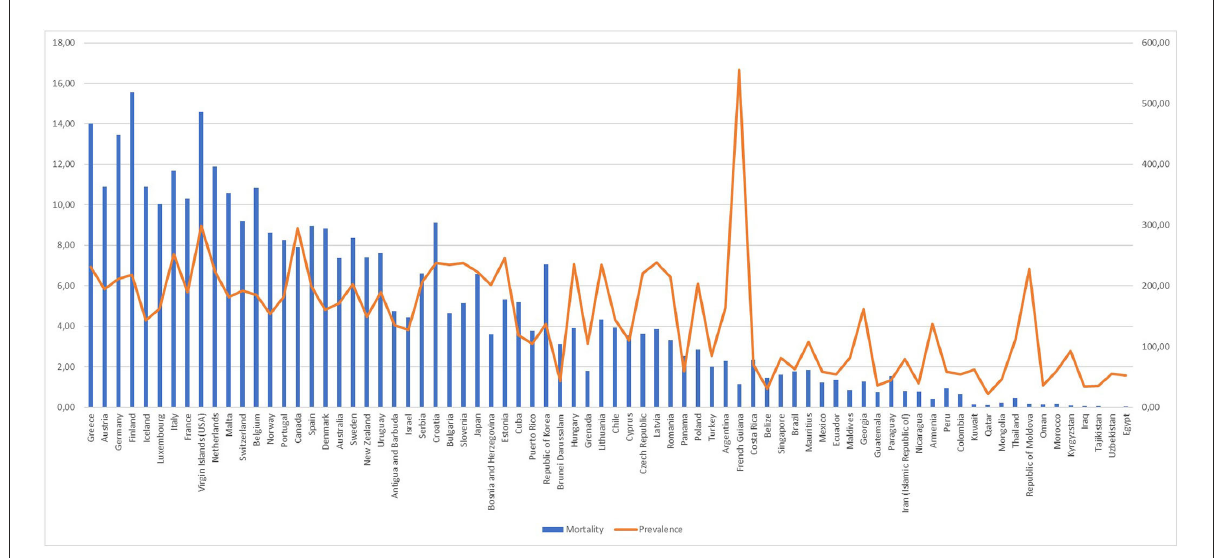
FIGURE4 Global prevalence of Parkinson’s disease in 2016 in comparison to mortality. Prevalence is expressed as the percentage of the population that is affected by the disease. Data for prevalence were extracted from the “Global, regional, and national burden of Parkinson’s disease, 1990–2016: a systematic analysis for the Global Burden of Disease Study